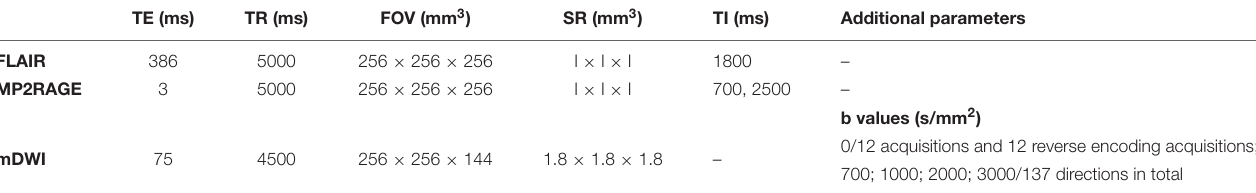
TABLE 1 | Acquisition parameters of each contrast in the MS